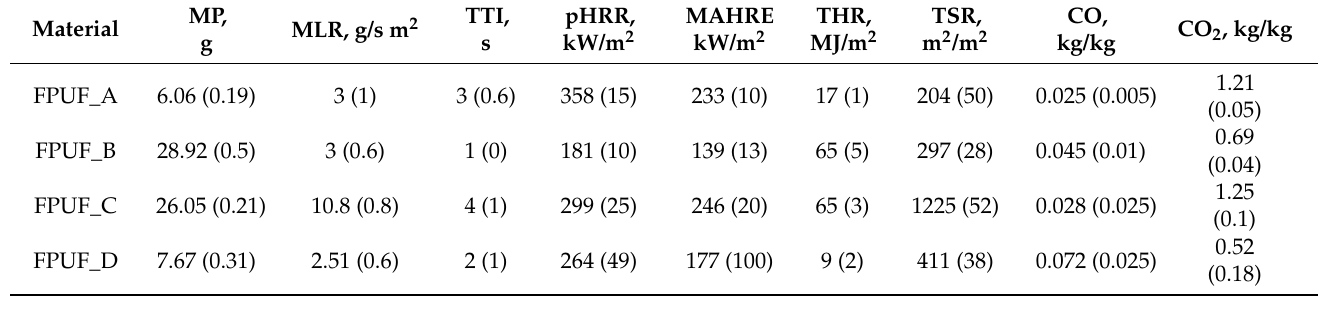
Table 3. Summary of cone calorimeter data.